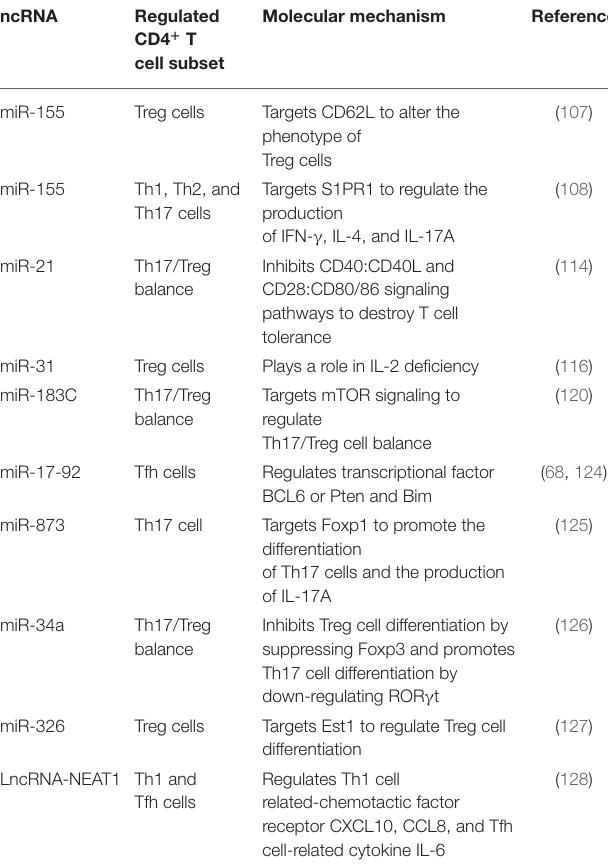
TABLE 8 | The roles of ncRNAs in the aberrant differentiation of CD4 + T cells in SLE.